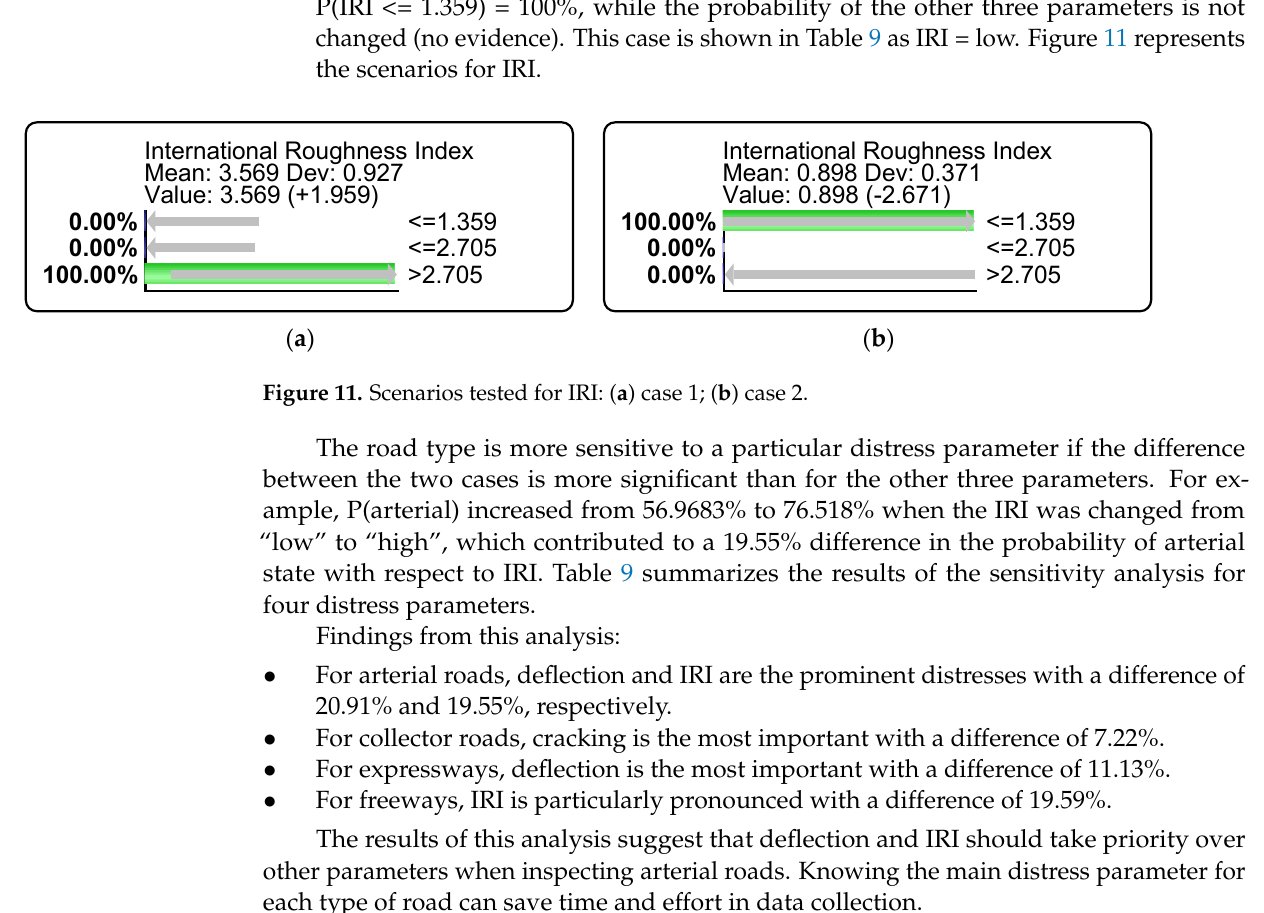
Table 9. Sensitivity analysis.